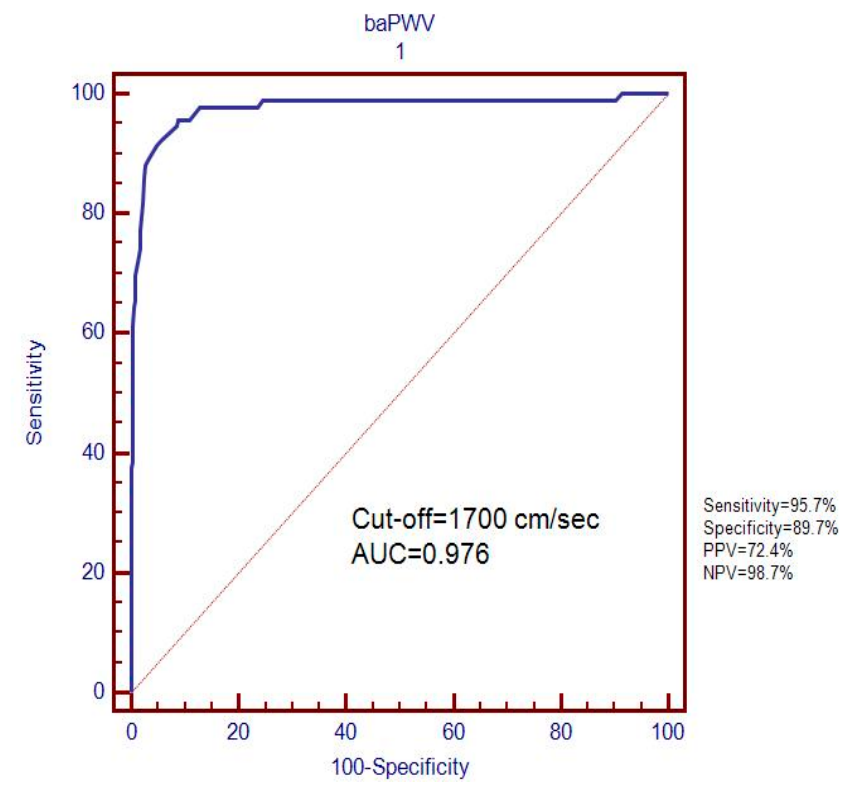
Figure 2. Determination of the optimum baPWV value for predicting the presence of microalbuminuria (20 μ g/min).